Question: Condense the content of this figure into a single sentence.
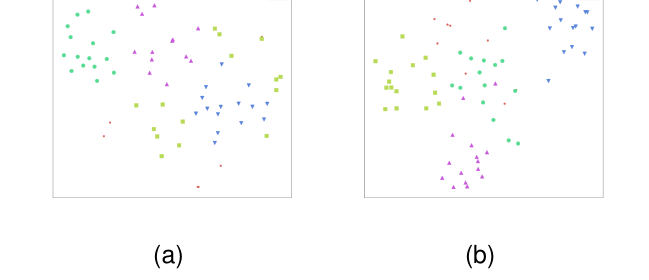
Answer: Qualitative visualization of model-based embedding before and after using intra-task mutual attention method on test tasks. Each figure shows the locations of PCA projected query embeddings (a) before and (b) after the adaptation of IMAformer. Values below are the 5-way 15-shot few-shot task before and after the adaptation. Obviously, the embedding adaptation step of IMAformer pushes the query embeddings toward their own clusters, such that they can better fits the test data of its categories.